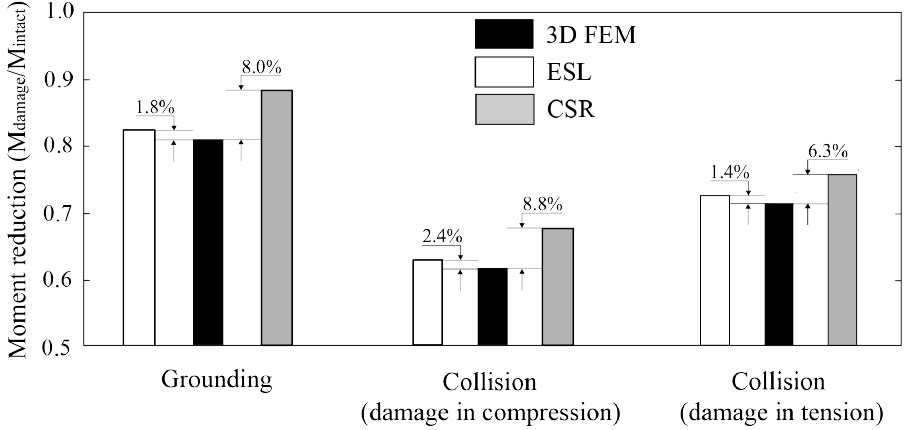
Figure 18. The moment reduction ratio of horizontal bending moment in grounding and collision cases for the 3D FEM, ESL, and CSR